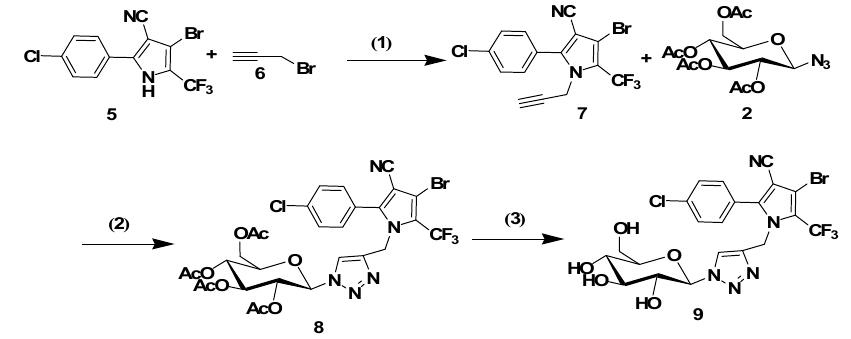
Scheme 2. Synthesis of glucose conjugate 9 with a space arm of methene group. Reagents and conditions: